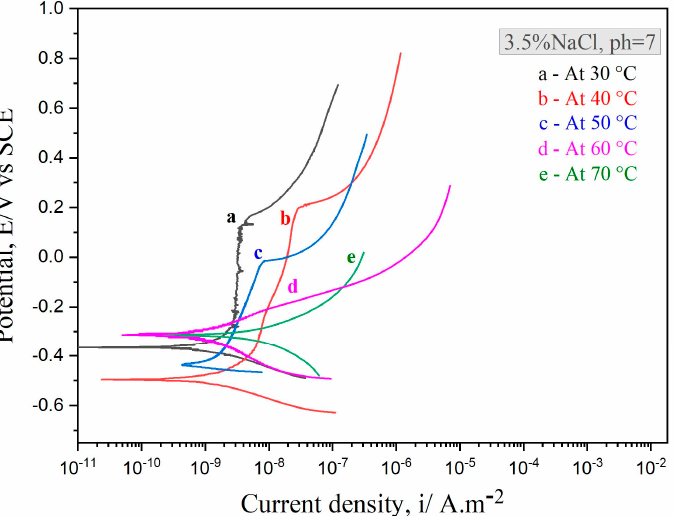
Figure 7. Potentiodynamic polarization curves of the Fe 49.7 Cr 1.8 Mn 1.9 Mo 7.4 W 1.6 B 15.2 C 3.8 Si 2.4 coatings with vacuum heat treatment at 650 °C under the conditions of 30 °C, 40 °C, 50 °C, 60 °C, and 70 °C in 3.5% NaCl solution.